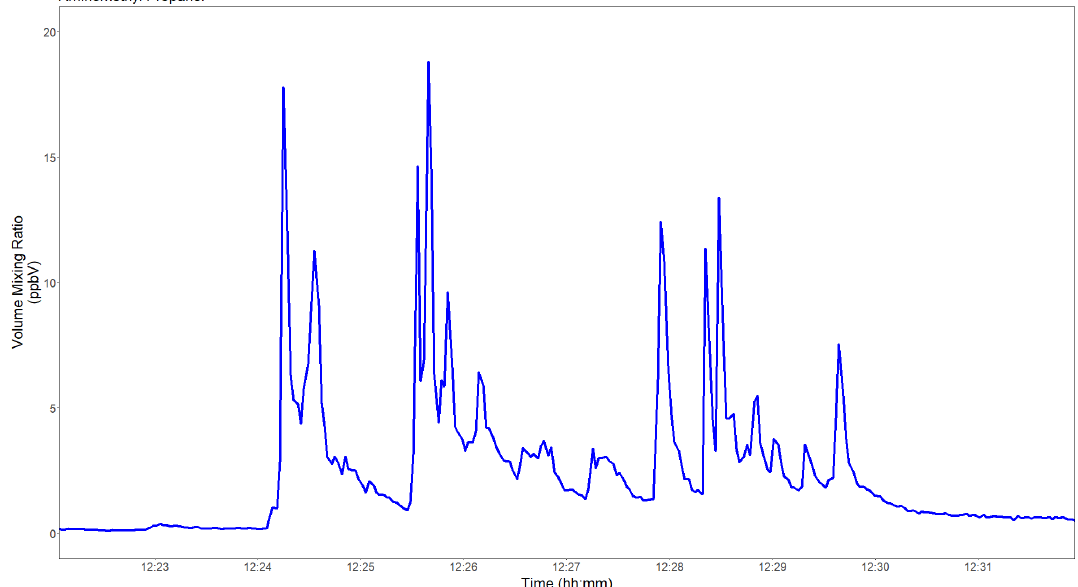
Figure 7. Time series (1Hz) of 2-amino-2-methylpropan-1-ol (AMP) as measured when ∼ 25ppmv of this industrial amine was deliberately released into the air at approximately 1m distance from the instrument inlet.